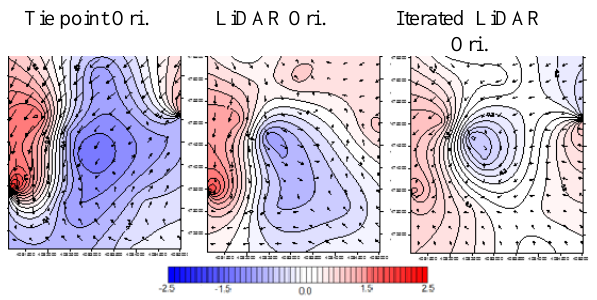
Figure 14: 2001 Check Points Analyse